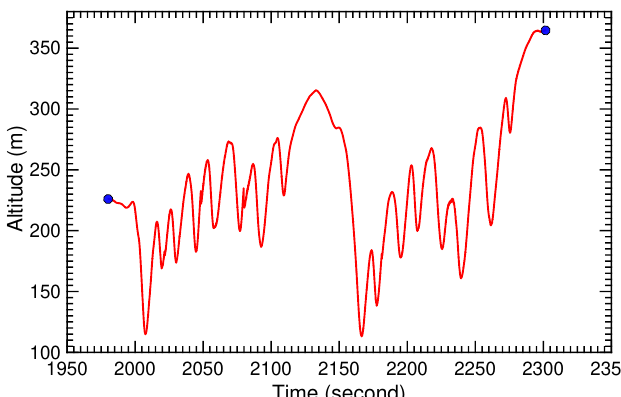
Figure 26. Recorded kite altitude for two pumping cycles. The origin of the time scale in this and subsequent time-history diagrams is not synchronized with the launch event.